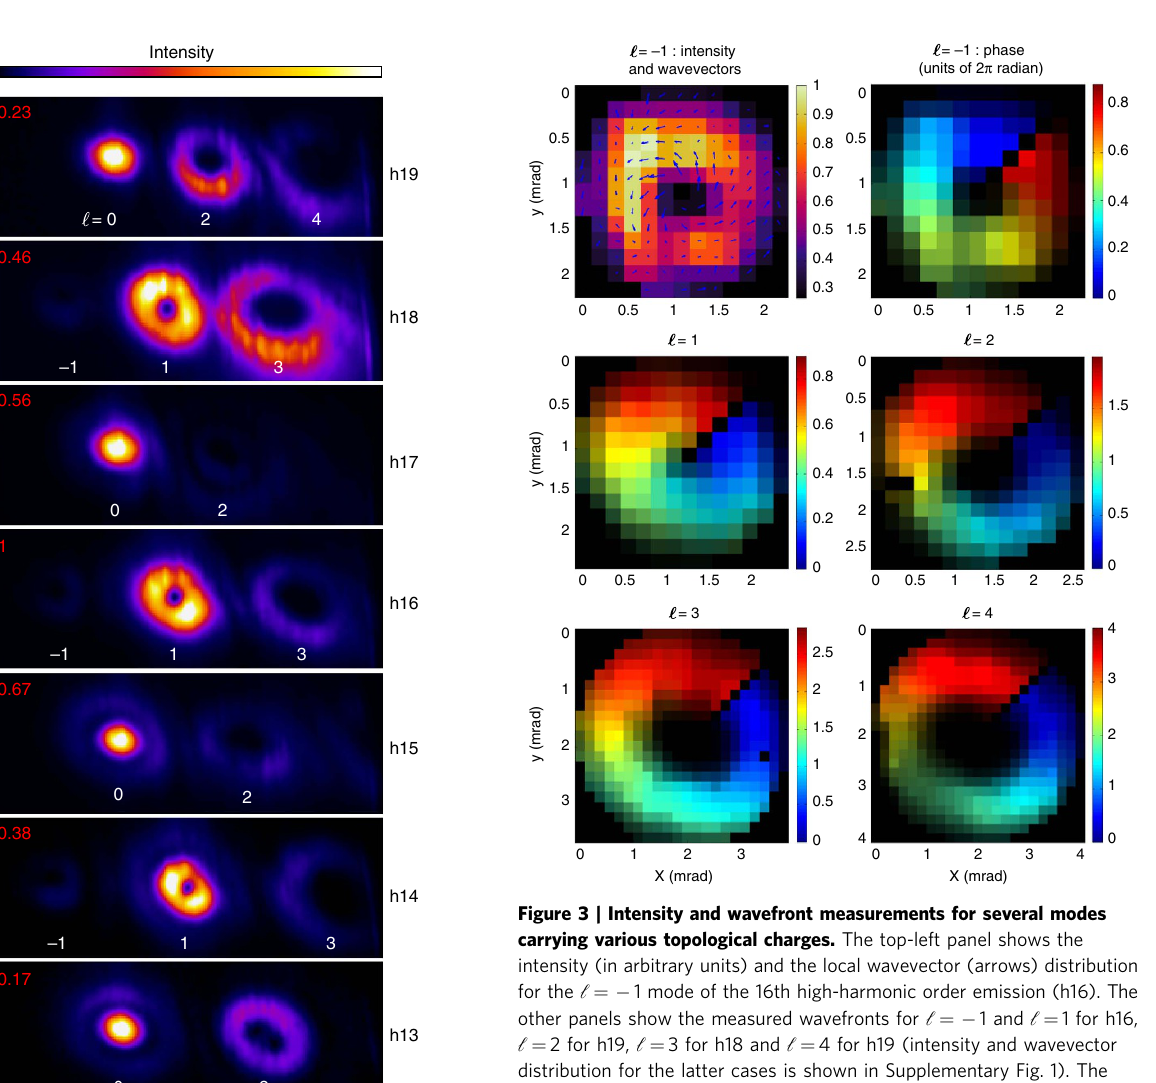
the two beams before being focused by two independent lenses into a 1-mm long argon gas cell. In one arm of the interferometer, the 2 o beam is converted from a Gaussian to a Laguerre- Gaussian mode with c 2 o ¼ 1, using a spiral phase plate 21 . No OAM is imparted on the o beam ( c o ¼ 0). The crossing angle between the two beams in the gas cell can be adjusted by translating the last mirror of each arm. All modes generated at the